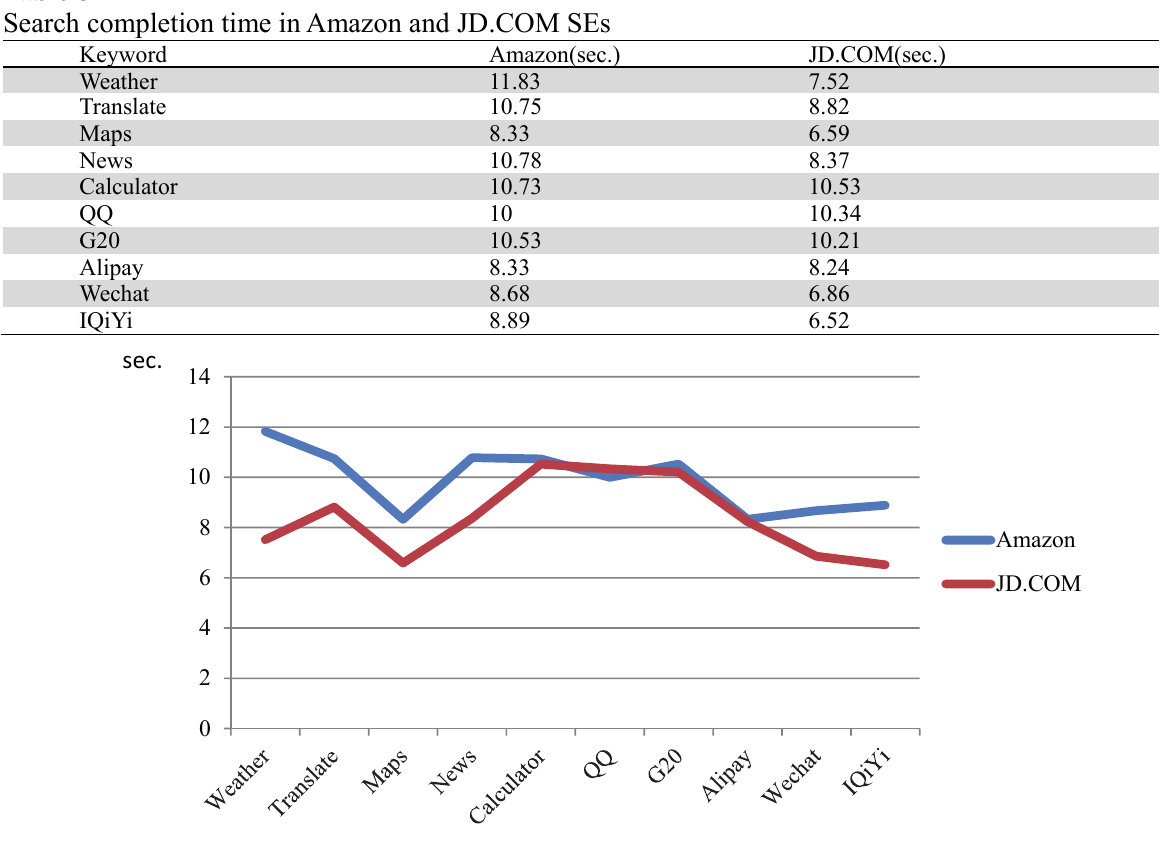
Fig. 7. Comparison of Search completion time in Amazon and JD.COM